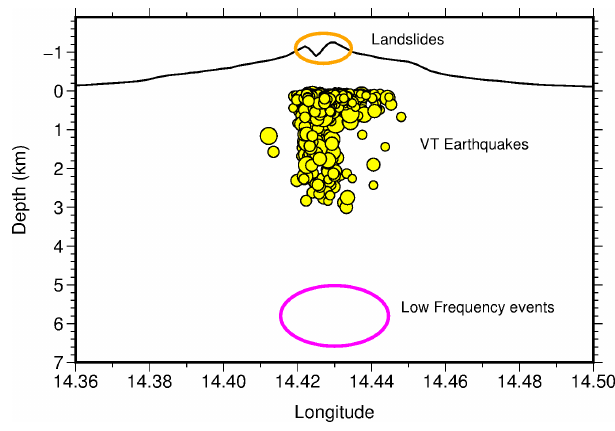
Figure 2. E-W vertical section of Mt. Vesuvius with the source lo- cation of VT earthquakes analyzed in this work. LF events usually occur in the seismogenic volume shown by the magenta ellipse. Or- ange ellipse identifies the area where local landslides